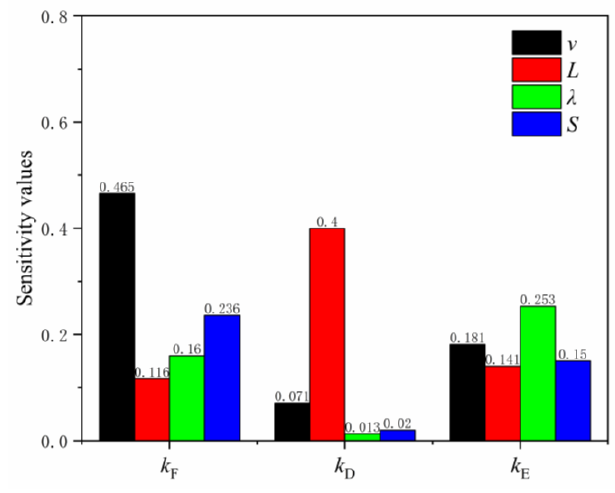
Figure 22. Sensitivity values of various performance parameters. Given the sensitivity values for rockfall velocity ( v ), ring diameter ( L ), ring net aspect ratio ( λ ), and the ratio of the loading area to ring net area ( S ) (0.717, 0.656 0.580, and 0.406, respectively), the degree of influence of these parameters was as follows: v > L > λ > S .